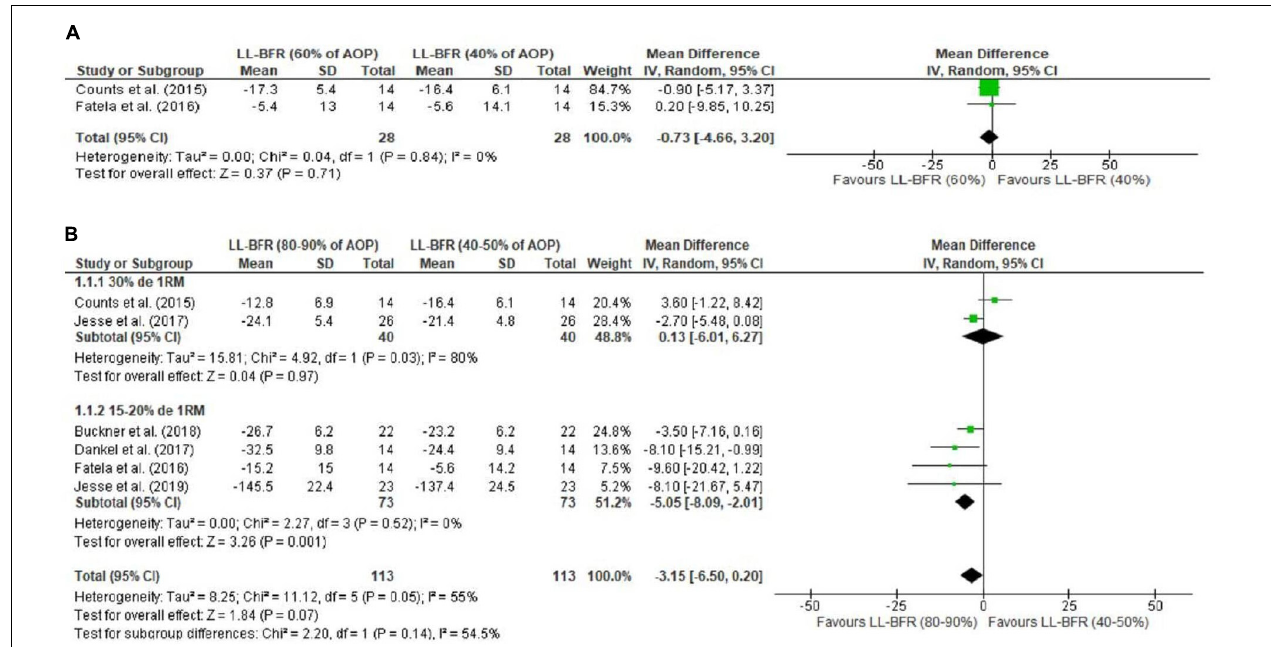
FIGURE 2 | Forest plot illustrating the combined effects for touch MVC torque of: (A) LL-RE with BFR pressure of 40% AOP vs. RE-LL with BFR pressure of 60% AOP; (B) LL-RE with BFR pressure of 40–50% AOP vs. LL-RE with BFR pressure of 80–90% AOP. 1RM: 1 repetition maximum; 95%CI: Confidence interval; AOP: arterial occlusion pressure; LL-BFR: low load + blood flow restriction; LL: low load; SD: standard deviation.